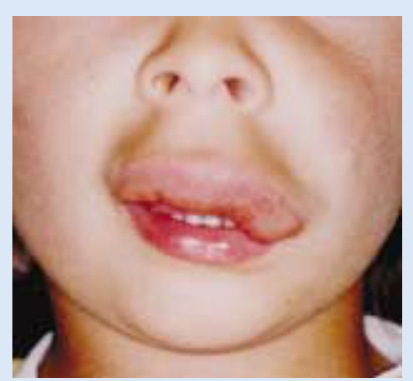
Fig. 5b. Lymphatic malformation of the upper